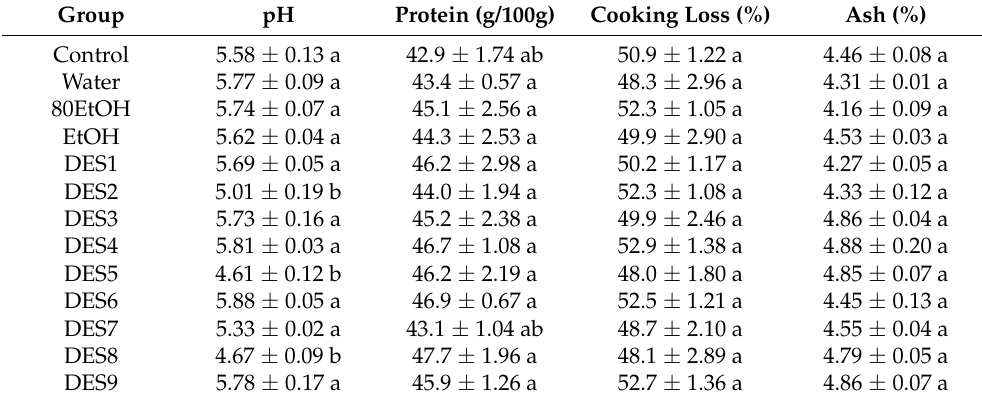
Table 3. Chemical composition, cooking loss, and pH of the beef patties with different ginger extracts. Group pH Protein (g/100g) Cooking Loss